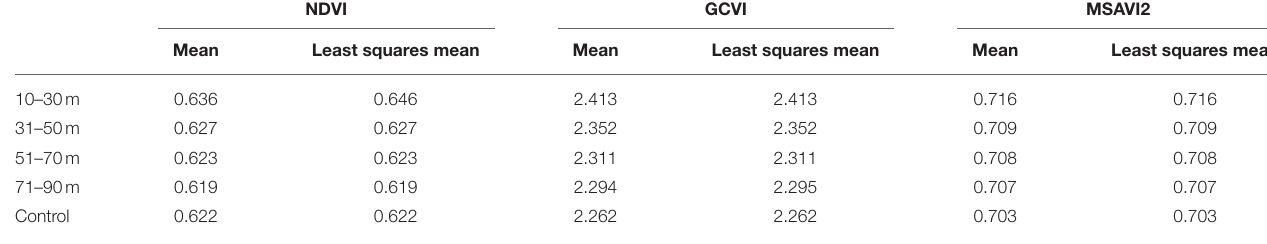
TABLE 4 | Mean and LS means across all distance classes and control for all three VIs.